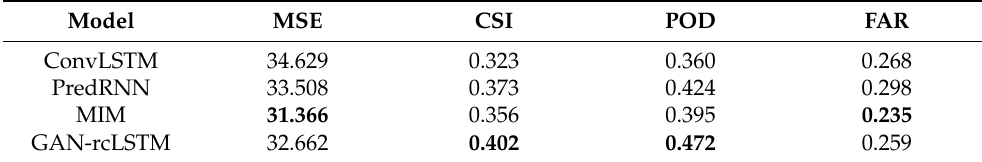
Table 4. Quantitative accuracy metrics of prediction results for different methods at a lead of 30 frames.